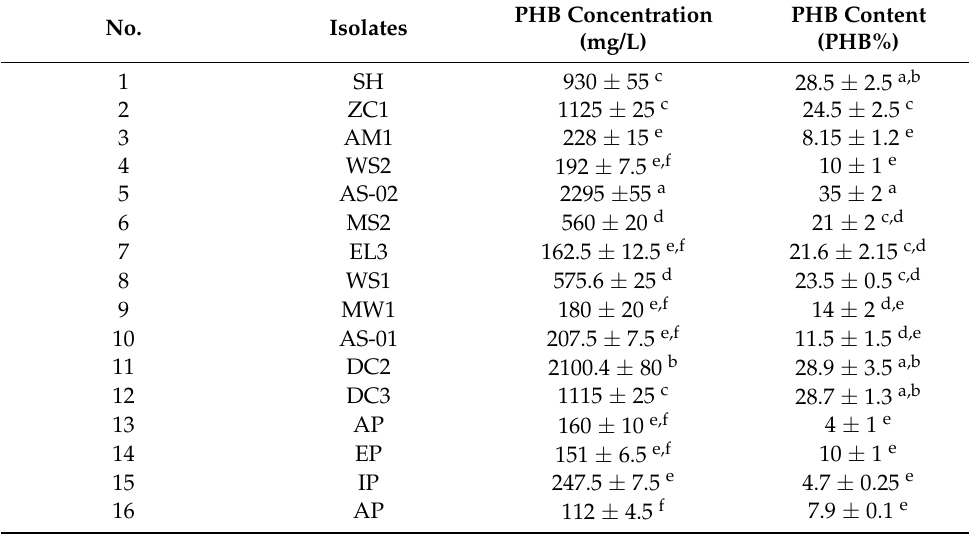
Table 1. Amount of PHB production by the different bacterial isolates. The ANOVA test was carried out by using SPSS 21 comparisons among means ± SE standard error ( n = 3); different letters show significance at p = 0.05 level based on Duncan’s multiple range